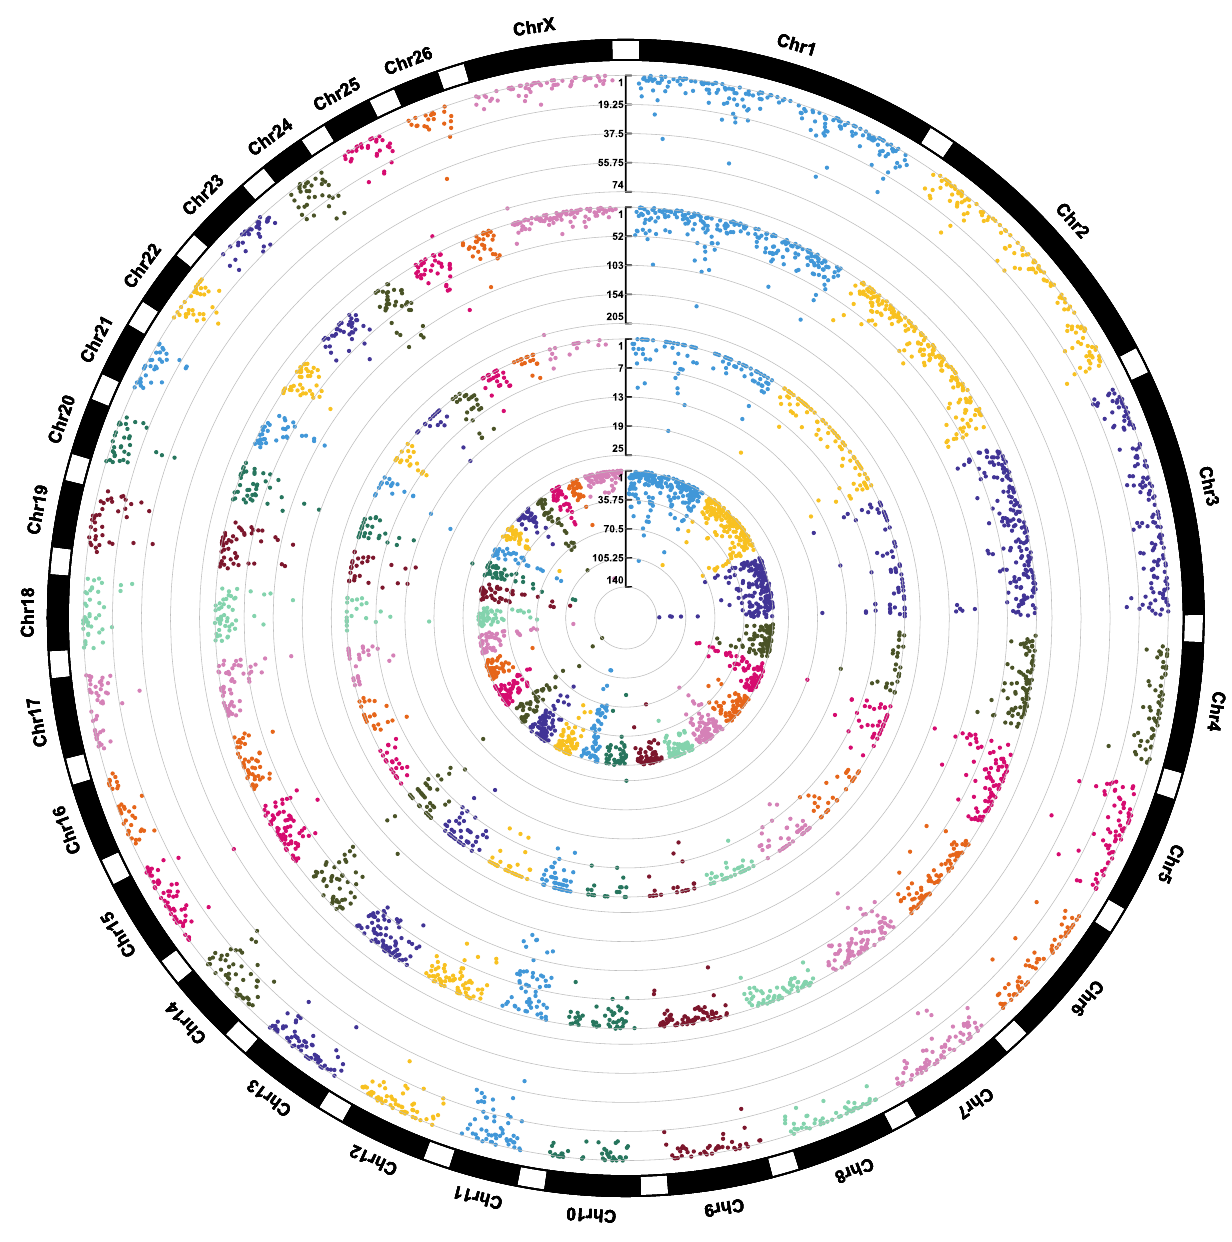
first and second inner layers, respectively. The common and Lori-Bakhtiari specific SNPs are positioned in the third and fourth inner layers, respectively. Vertical lines in each layer represent the number of SNPs in that